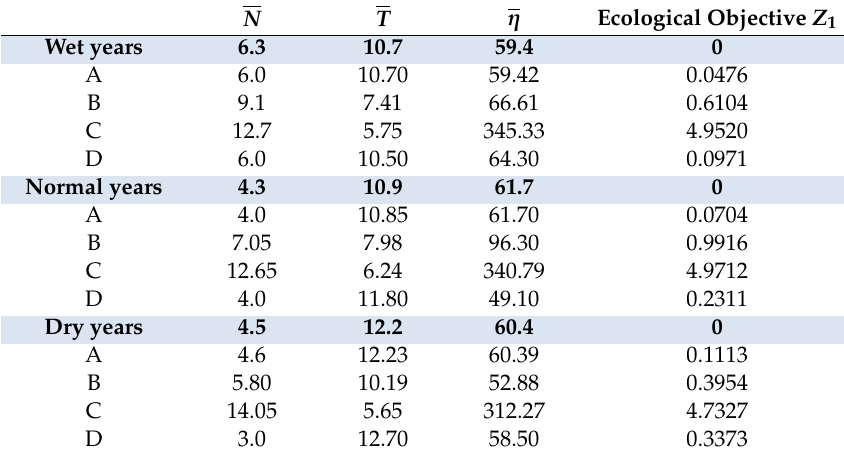
Table 6. Comparison of three ecological parameters.